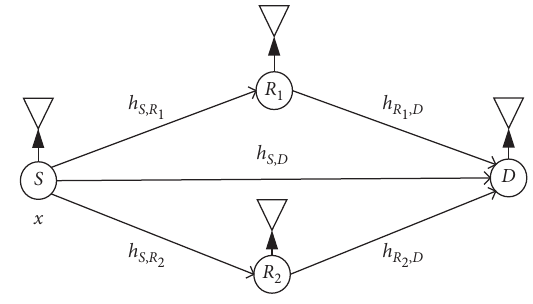
Figure 1: Relay cooperative transmission